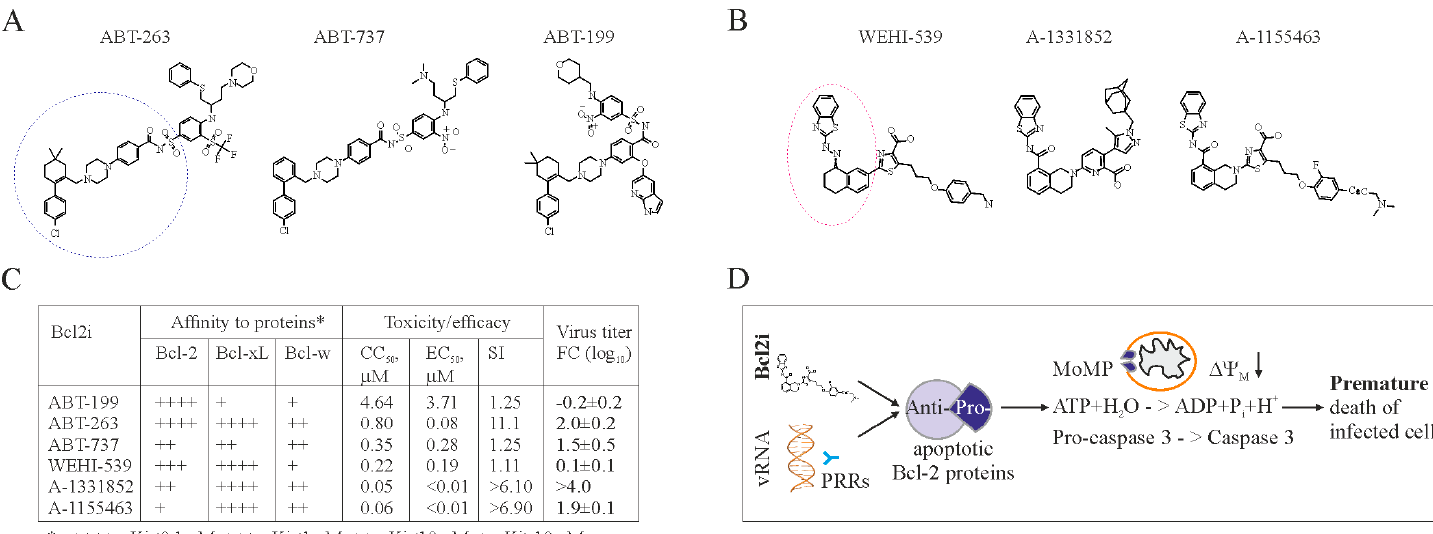
Figure 2. Bcl-2 inhibitors (Bcl2i) facilitate Bcl-2-dependent apoptosis in cells containing viral RNA. ( A , B ) Structures of ABT-263, ABT-737, ABT-199, WEHI-539, A-1331852, and A-1155463 revealed that these molecules fall into two distinct classes. Core structures are highlighted. ( C ) Table showing Bcl2i antiviral activities and affinities for three Bcl-2 proteins. “+” indicates inhibitory effect. Increased inhibition is marked by a higher “+” designation. ( D ) Schematic diagram showing how chemical inhibitors of Bcl-2 proteins induce premature death of cells containing viral nucleic acids. Bcl: B-cell lymphoma; CC 50 : half-maximum cytotoxic concentration; EC 50 : half-maximum efficacy concentration; SI: selectivity index; FC: fold-change; PRRs: pattern recognition